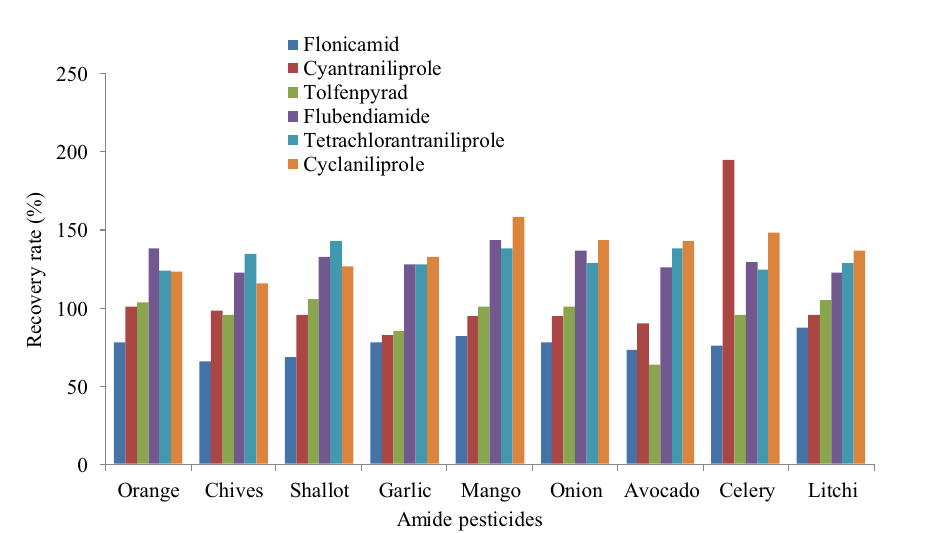
Figure 6. Different recovery of amide pesticides with PSA